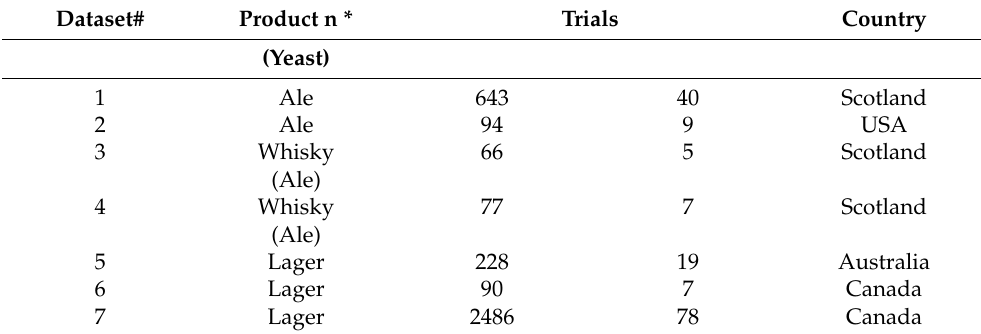
Table 1. Fermentations